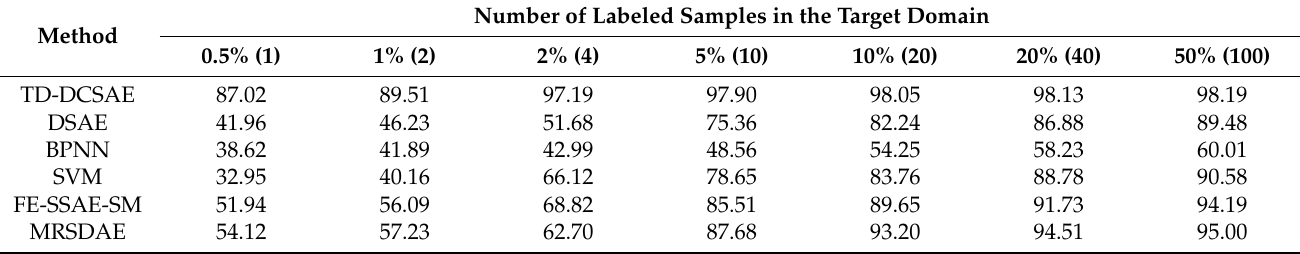
Table 5. The accuracy of different methods under different number of labeled samples in the target domain.